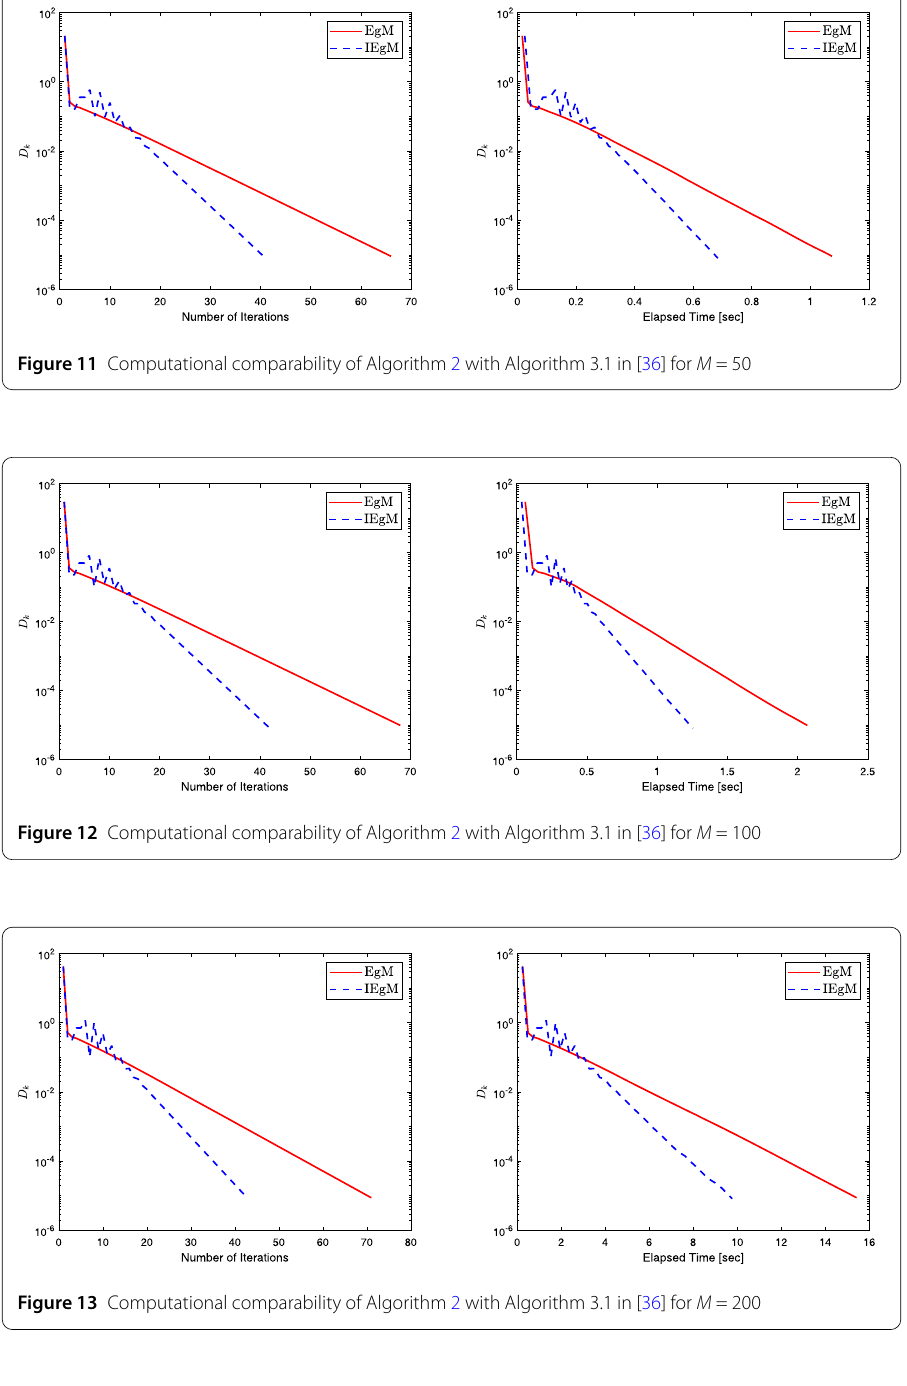
Table 2 Numerical data for Figs. 10, 11, 12, 13 M Number of iterations Execution time in seconds Algorithm 2 Algorithm 3.1 in [36] Algorithm